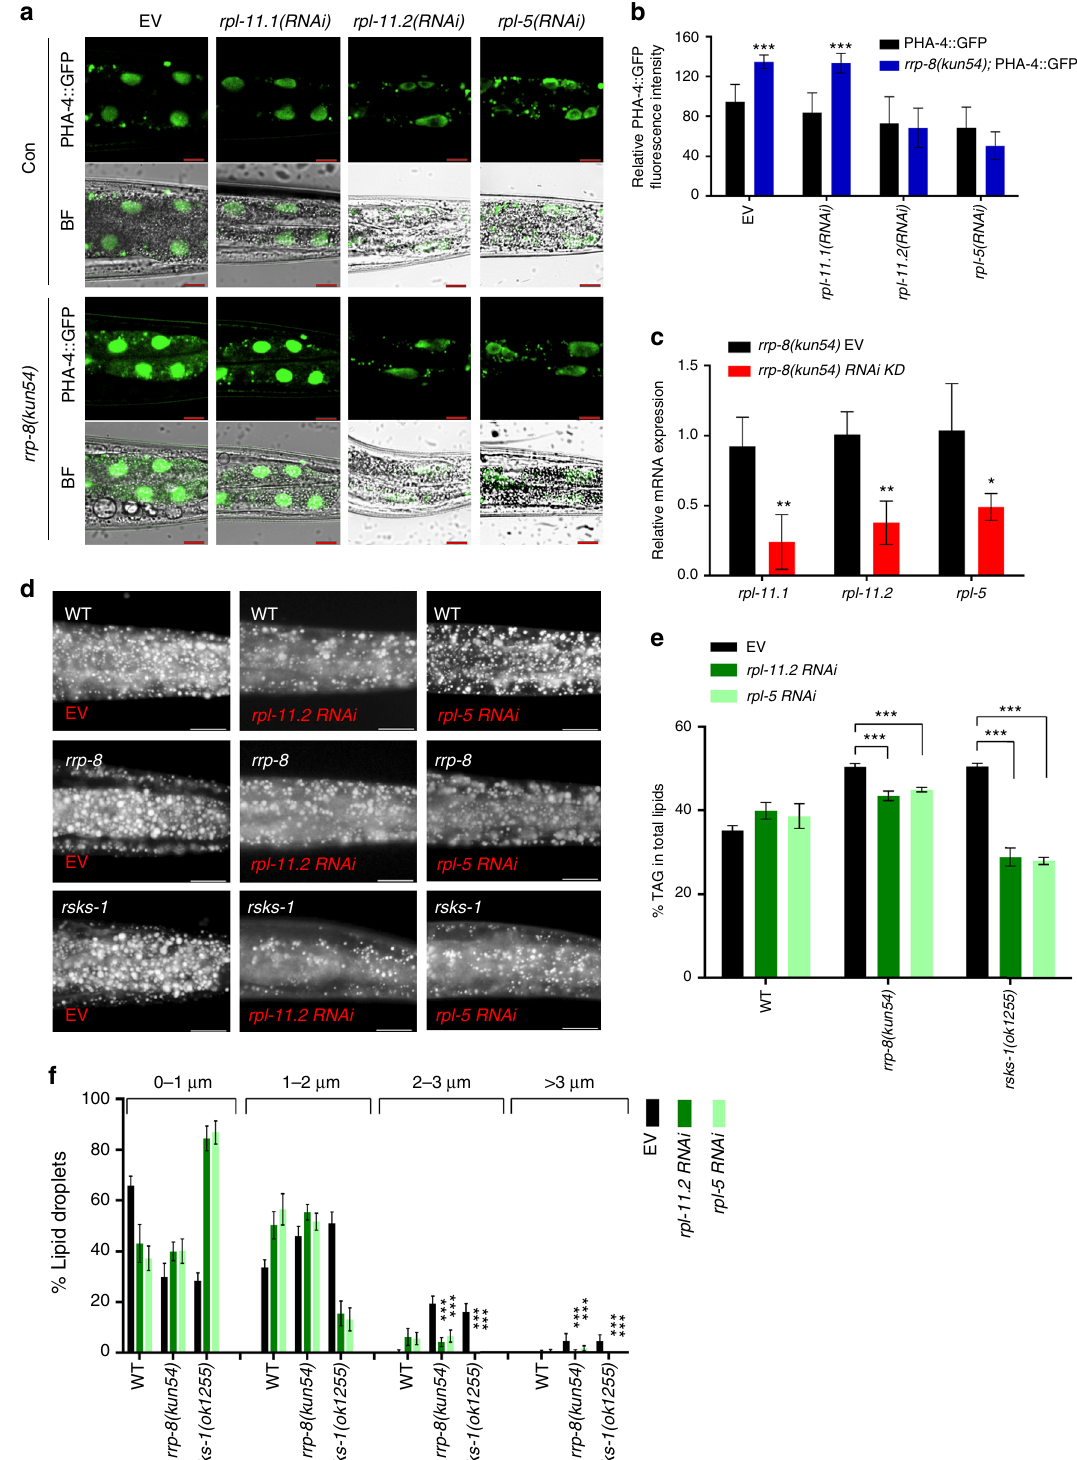
worms were transferred to prepared NGM plates for RNAi treatment. Young adult worms were collected for further analyses after 48h, unless speci fi cally indicated. The WT strain was Bristol N2. The complete worm strains, including the trans- genic strains used in the present study, are listed in Supplementary Table 2.The sequence information of primers used in this study was listed in Supplementary Table